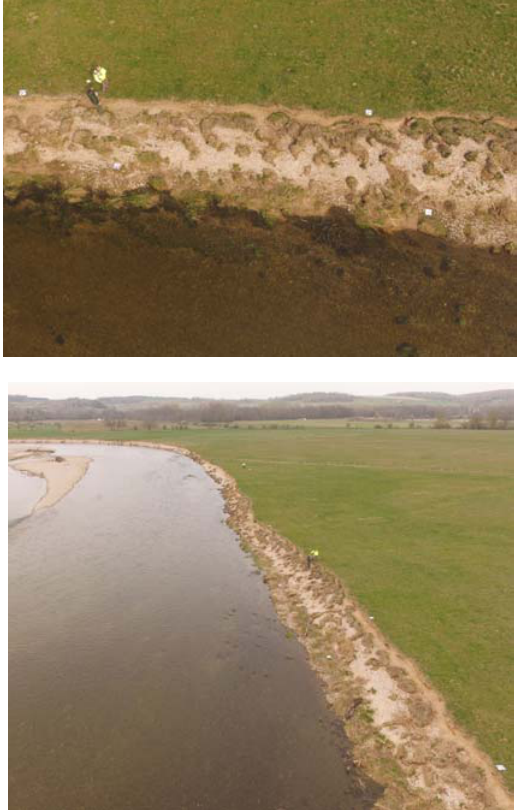
Figure 2: Nadiral (top) and oblique (down) images of the studied bank.